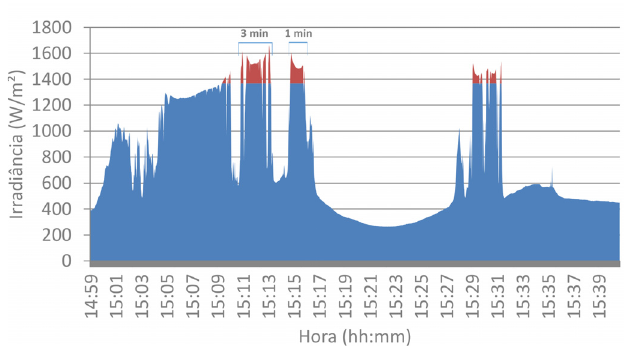
Fig. 4. Cloud-edge+cloud-enhancement overirradiance events at one of the eight Evaluation Sites reported in this paper, in which irradiance peaks over 1400 W/m 2 were measured for considerably long (min) periods, as shown in Table